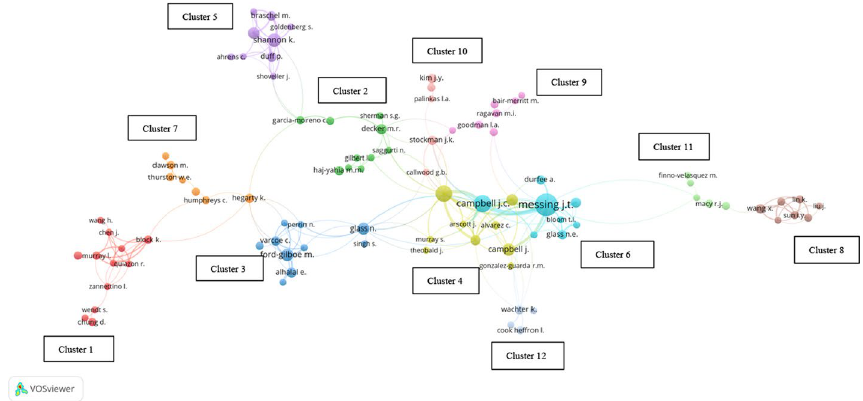
Fig. 4 Visualisation map of co-authorship